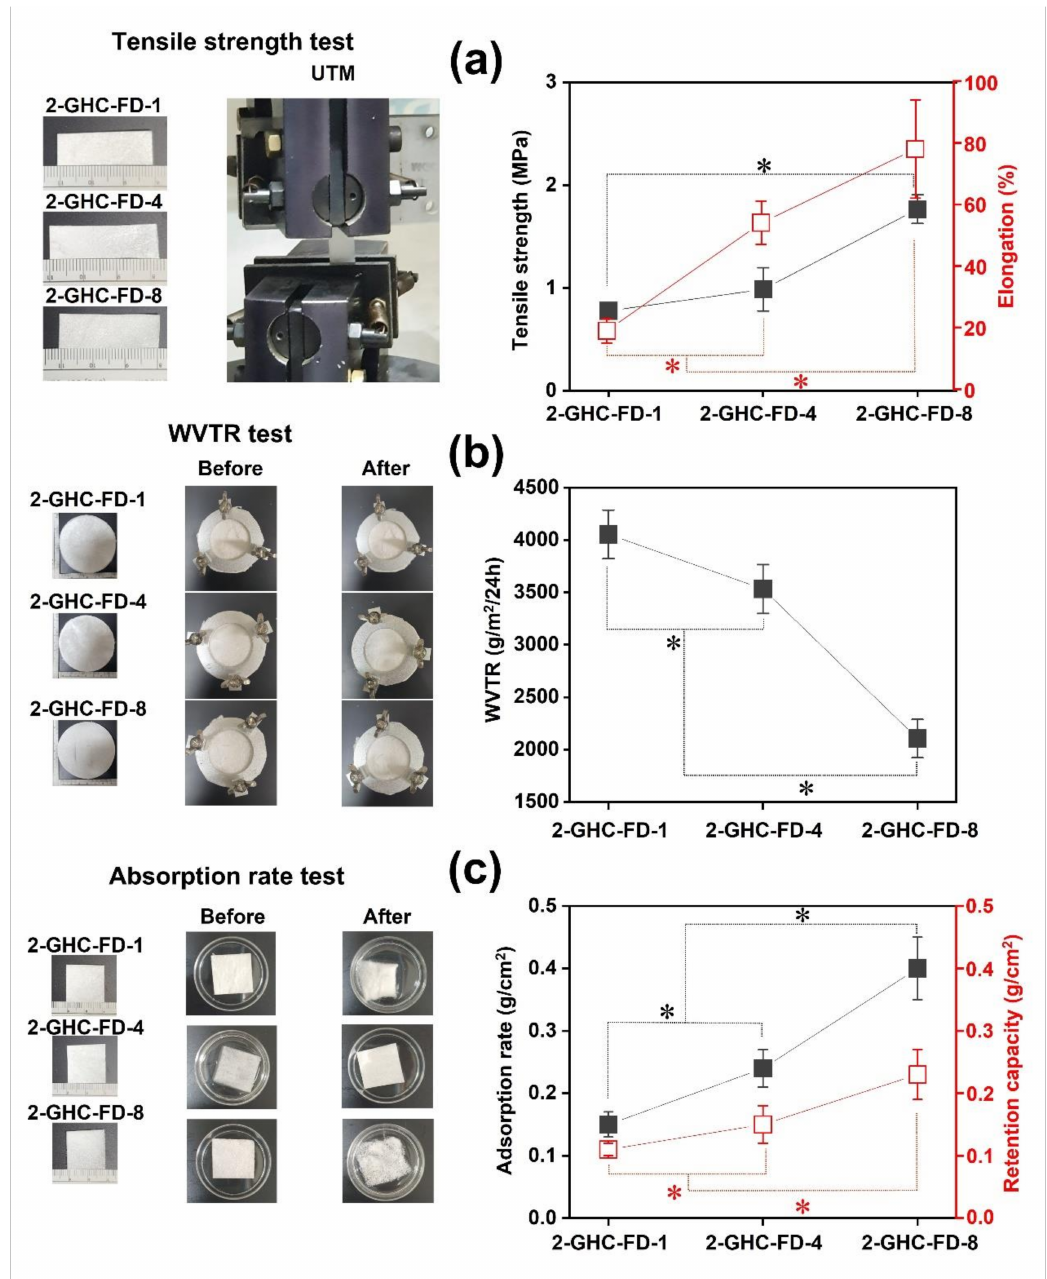
Figure 4. ( a ) Tensile strengths and elongations, ( b )WVTR, and ( c ) absorption rate and retention capacity of 2-GHC-FD-1, GHC-FD-4, and GHC-FD-8. The test was performed five times. The statistical significance was indicated by an asterisk (*) for p < 0.05. The results of FD samples compared each other. In the tensile strength of ( a ) graph, 2-GHC-FD-8 had significant differences as compared to 2-GHC-FD-1. The elongation result of 2-GHC-FD-8 had significant differences as compared to those of 2-GHC-FD-1 and 2-GHC-FD-4. In WVTR results of ( b ) graph, 2-GHC-FD-8 had significant differences as compared to 2-GHC-FD-1 and GHC-FD-4. In ( c ) graph, the adsorption rate and retention capacity of 20GHC-FD-8 had